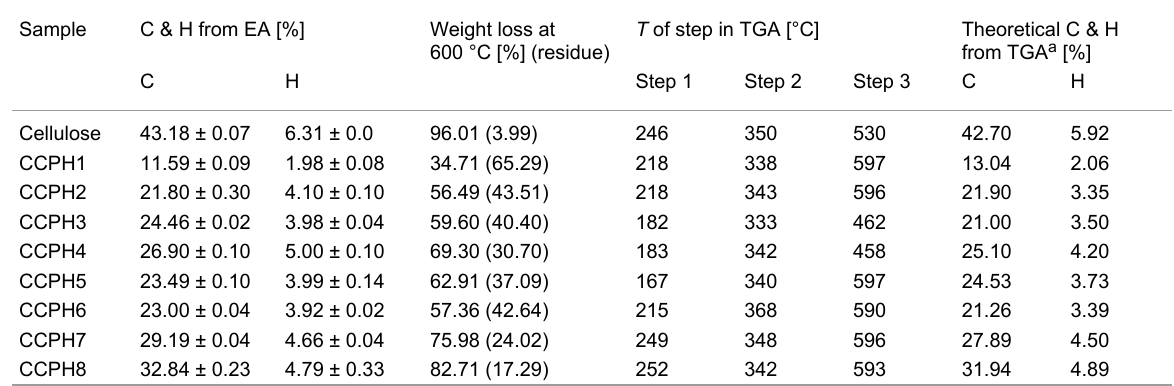
Table 5: EA and TGA data obtained for CCPHs. No N was detected in EA; the detection limit of the instrument is 0.3%. Sample